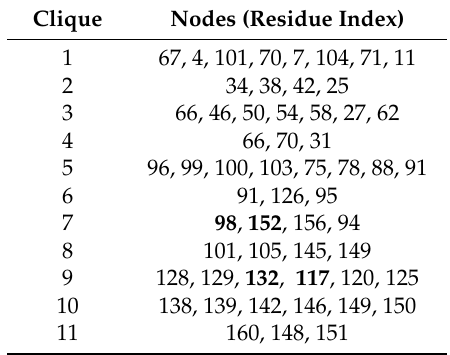
Table 1. Typical 3-cliques found in a T4 phage lysozyme amino-acid network